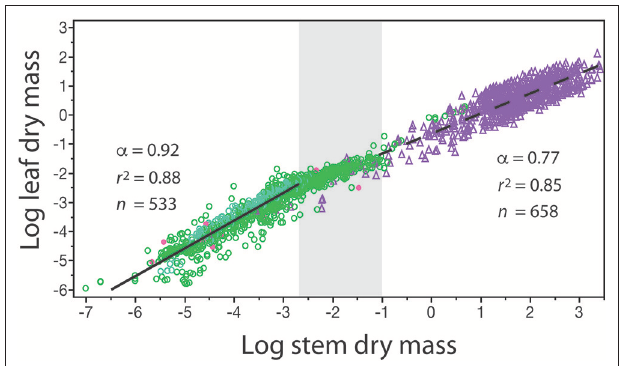
FIGURE 3 | Bivariate plot of log 10 -transformed standing leaf dry mass vs. standing stem dry mass (original units in kg) for herbaceous non-woody plants (green circles) and woody plants (purple triangles). The gray area in the middle of the plot denotes the region where the β and α values of the solid and dashed regression curves numerically change. This area also corresponds to where cross sections through representative stems manifest observable amounts of secondary tissues. Red dots indicate data from non-vascular and vascular seedless species (e.g., algae and mosses, and ferns and lycophytes). See text for scaling formulas. Data taken from the primary botanical literature.